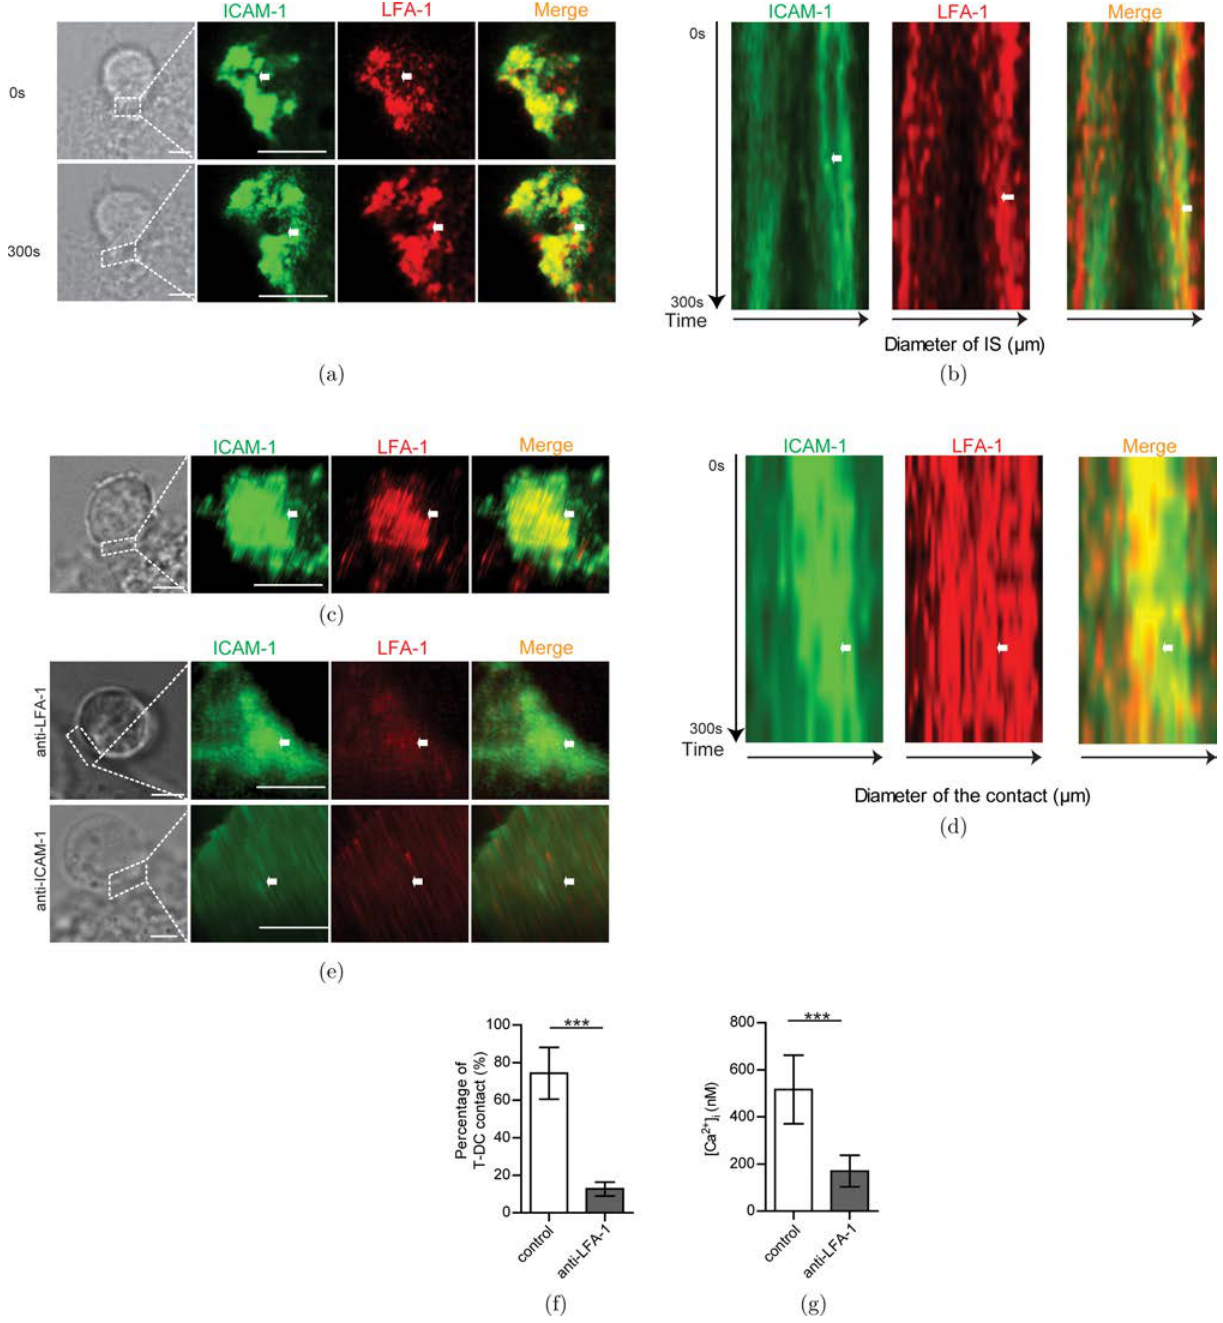
Fig. 5. The movement of ICAM-1 and LFA-1 in ISs: (a) The localization of ICAM-1 and LFA-1 at a bullseye IS that had ICAM-1 depletion in the center of the IS. It was measured at 0 s and 300 s after a T-cell contacted a DC. Bar ¼ 2 (cid:2) m. (b) Kymograph analysis of the dynamic change of ICAM-1 and LFA-1 along the diameter of the synapse from 0 s to 300 s. The white arrows in the panel indicate the trend of ICAM-1 and LFA-1 movement from the center to the periphery of the IS. (c) The localization of ICAM-1 and LFA-1 at T-DC contact with only ICAM-1 accumulation. (d) Kymograph analysis of the dynamic change of ICAM-1 and LFA-1 along the diameter of the synapse that only had ICAM-1 accumulation in the T-DC contact. (e) With treatment of anti-ICAM-1 antibody and anti-LFA-1 antibody, the localization of ICAM-1 and LFA-1 were measured at T-DC contact. (f) With/without treatment of anti-LFA-1 antibody, the percentage of T-DC contact was measured. (g) With/without treatment of anti-LFA-1 antibody, the concentration of calcium in the T-cell was measured. The arrows in ¯gures (b) and (d) point the movement of direction of accumulated ICAM-1 or LFA-1. The arrows in the ¯gure (a) showed the center of synapse. The arrows in the ¯gures (c) and (e) showed the interface of T- DC